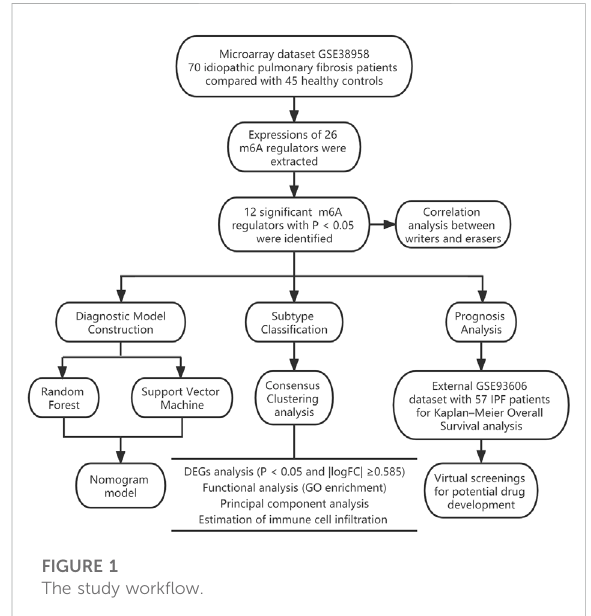
FIGURE 1 The study work fl